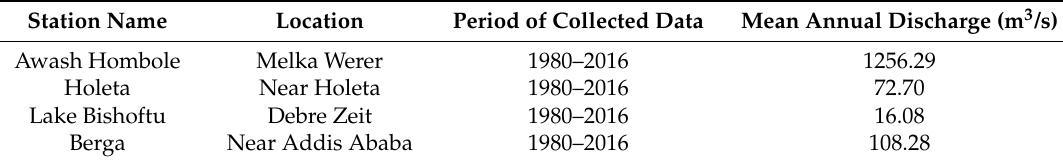
Table 2. Basic information of discharge gauging